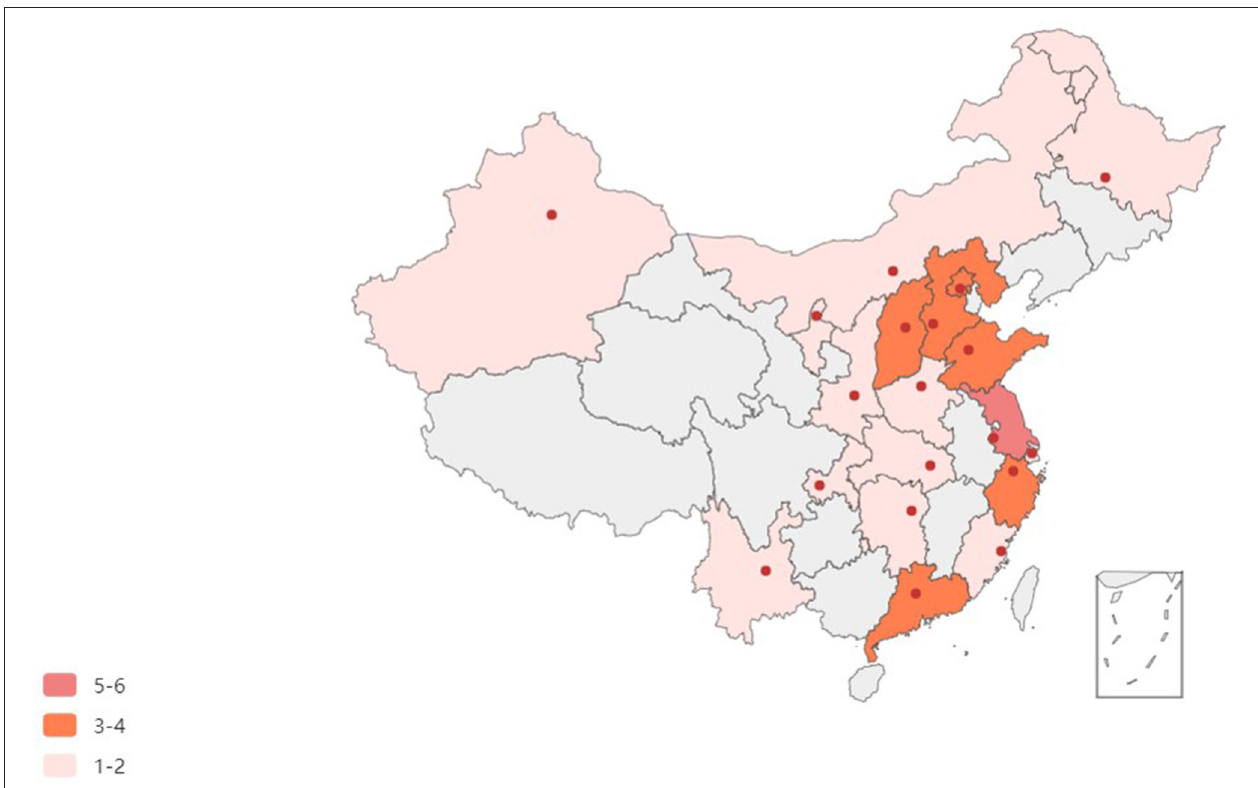
FIGURE 1 | Nationwide map of enrolled